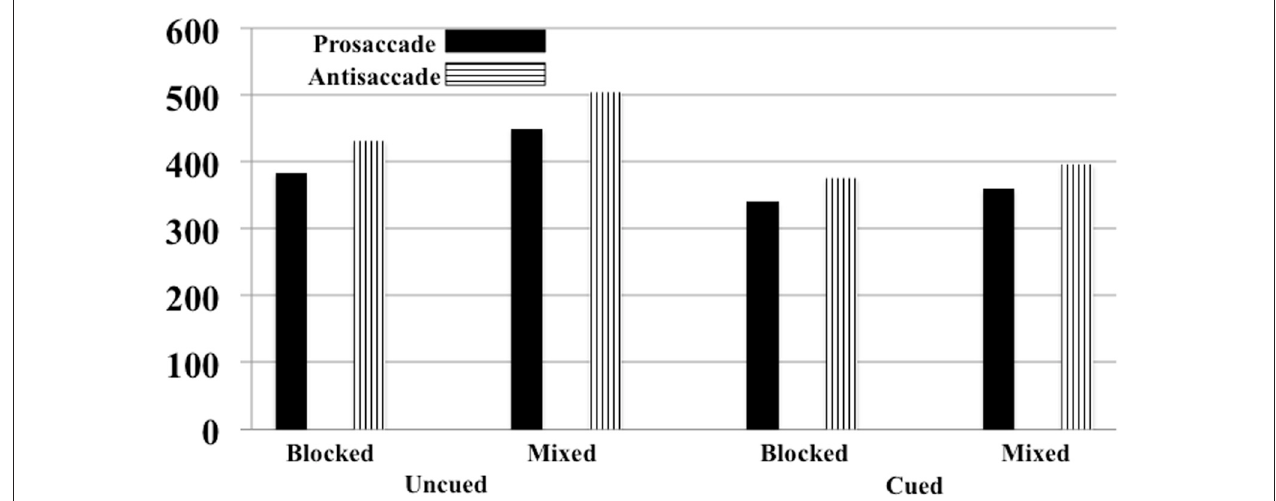
FIGURE 8 | Reaction time for moving the eyes from the center to the target for Experiment 2. This is presented separately for cued and uncued trials, blocked and mixed-choice procedure, and prosaccade and antisaccade eye movements. The SE of the means for the six conditions ranged from 4.44 to